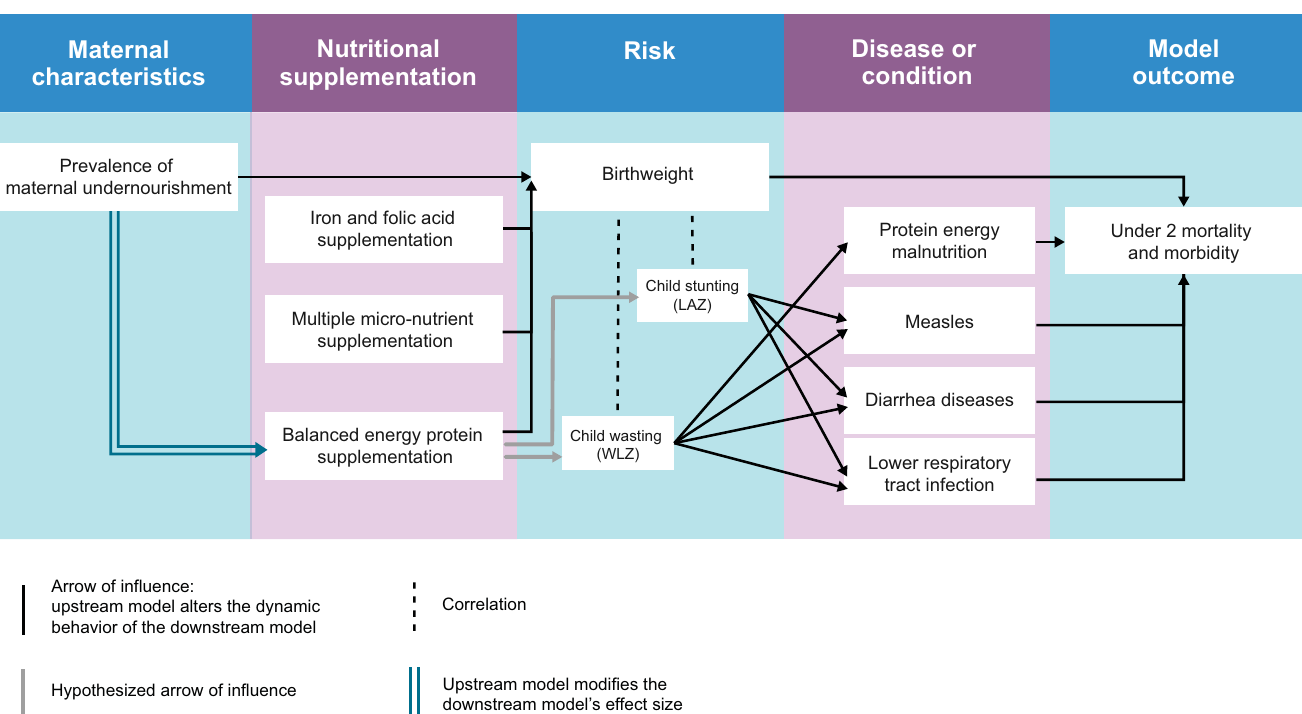
Fig 1. Model concept diagram. Logical causal flow of maternal characteristics and antenatal nutritional supplementation regimens on downstream effects and ultimate impact on mortality and morbidity in our microsimulation model. In GBD 2017, LBW is modeled to directly affect all-cause mortality among early (0 to 6 days) and late neonatal (7 to 27 days) age groups. Gray arrows denote effects with potential but inconclusive evidence. GBD, Global Burden of Disease; LAZ, length-for-age z-score; LBW, low birth weight; WLZ, weight-for-length z-score.